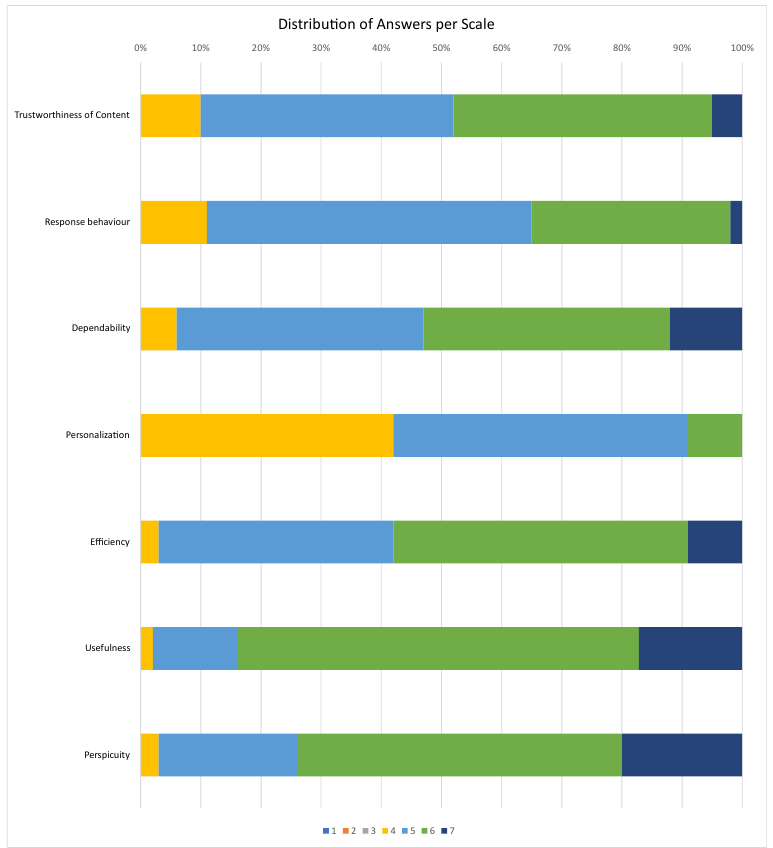
Figure 15. Distribution of answers per